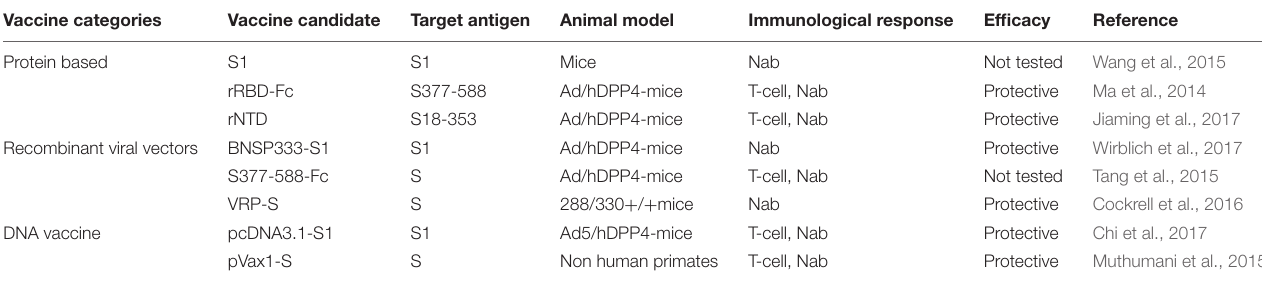
TABLE 4 | Categories of vaccine developed against MERS-CoV, their potential candidate, and their target long with their immunological response and efficacy. Vaccine